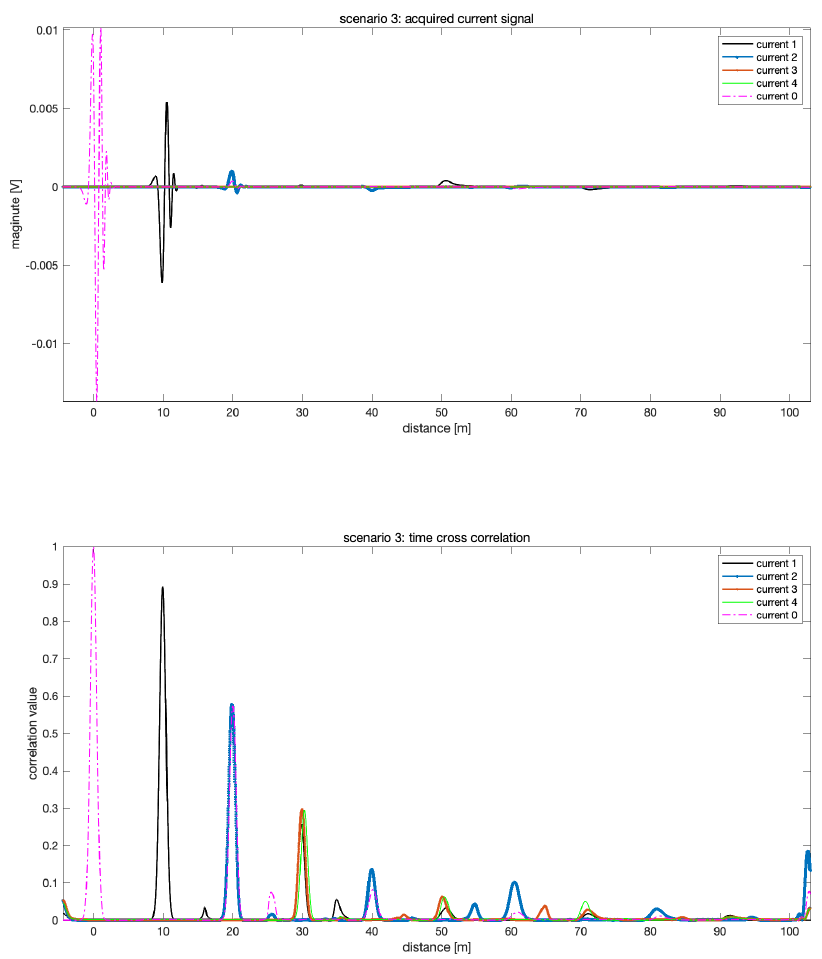
Figure 15. Fault localization results: scenario